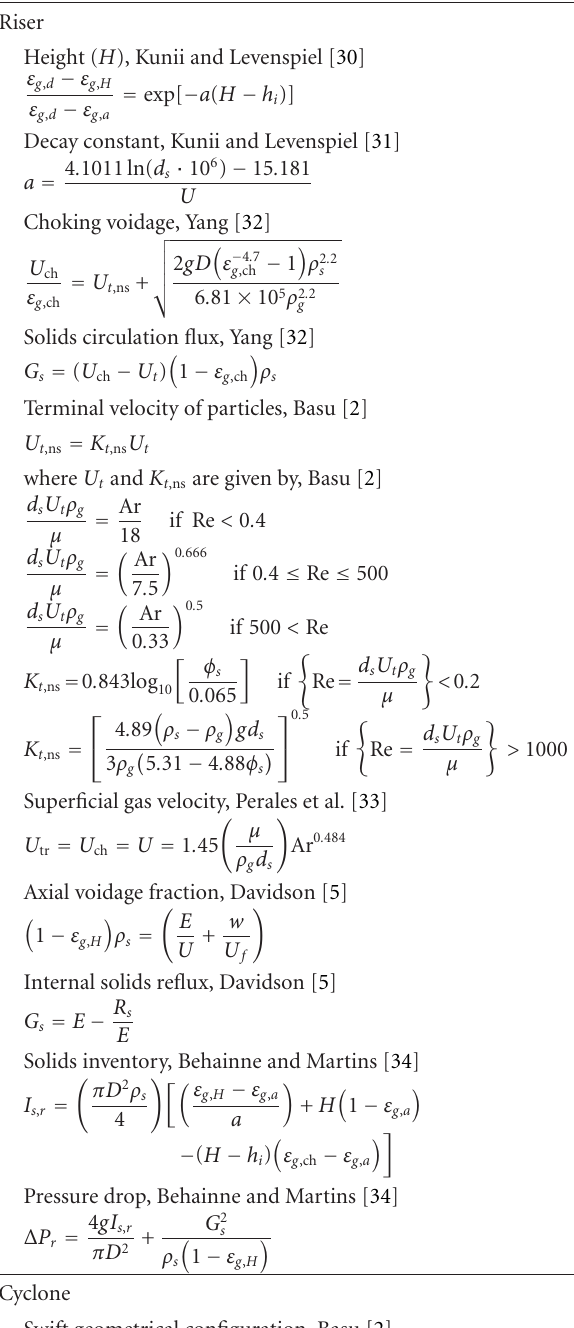
Table 3: Semiempirical CFB mathematical